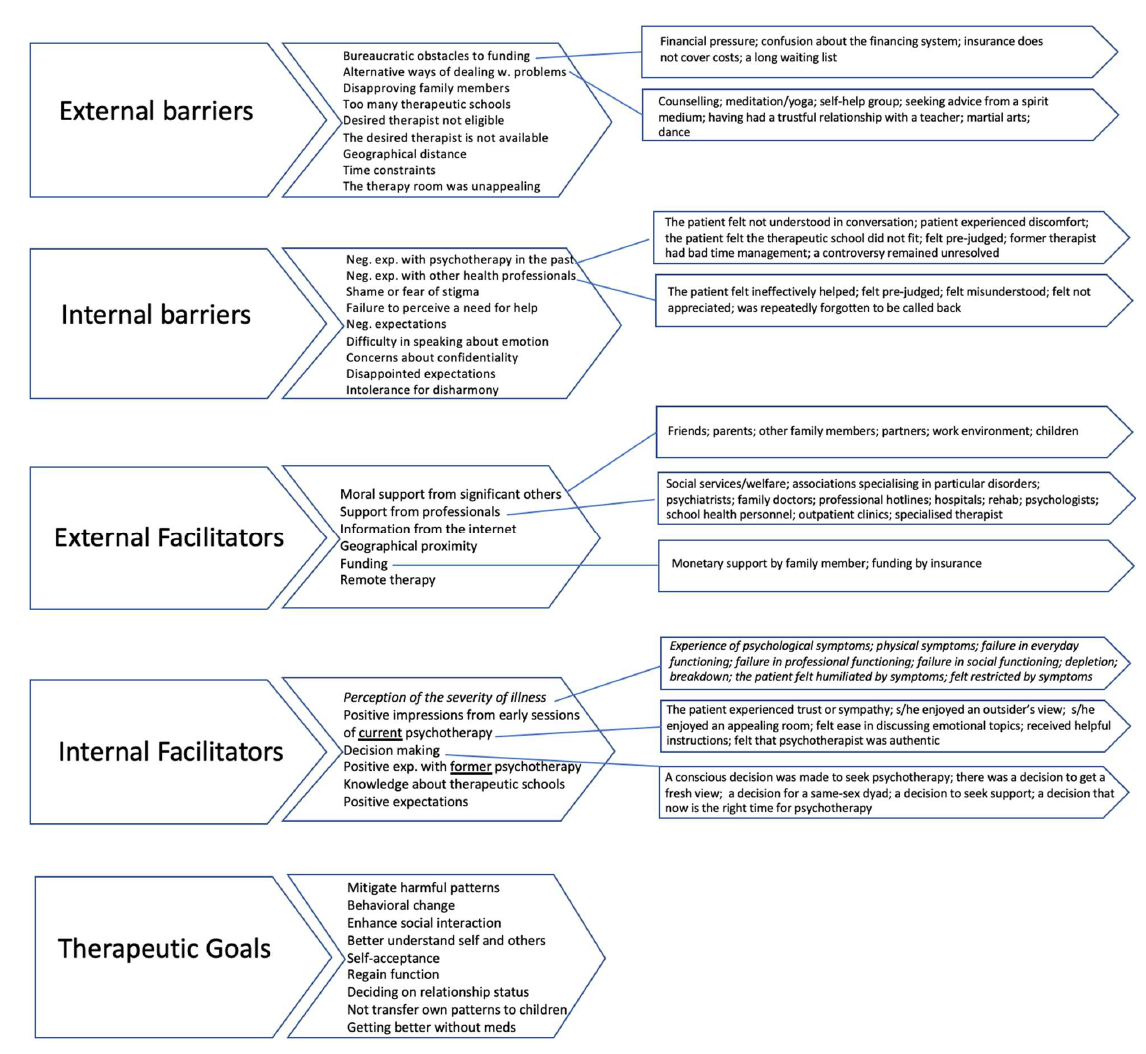
Figure 1. Code arrangements. First-order categories, second-order categories and third-order cate- gories from left to right. In the internal facilitator category, need (but not enabling) characteristics are pointed out in italics.